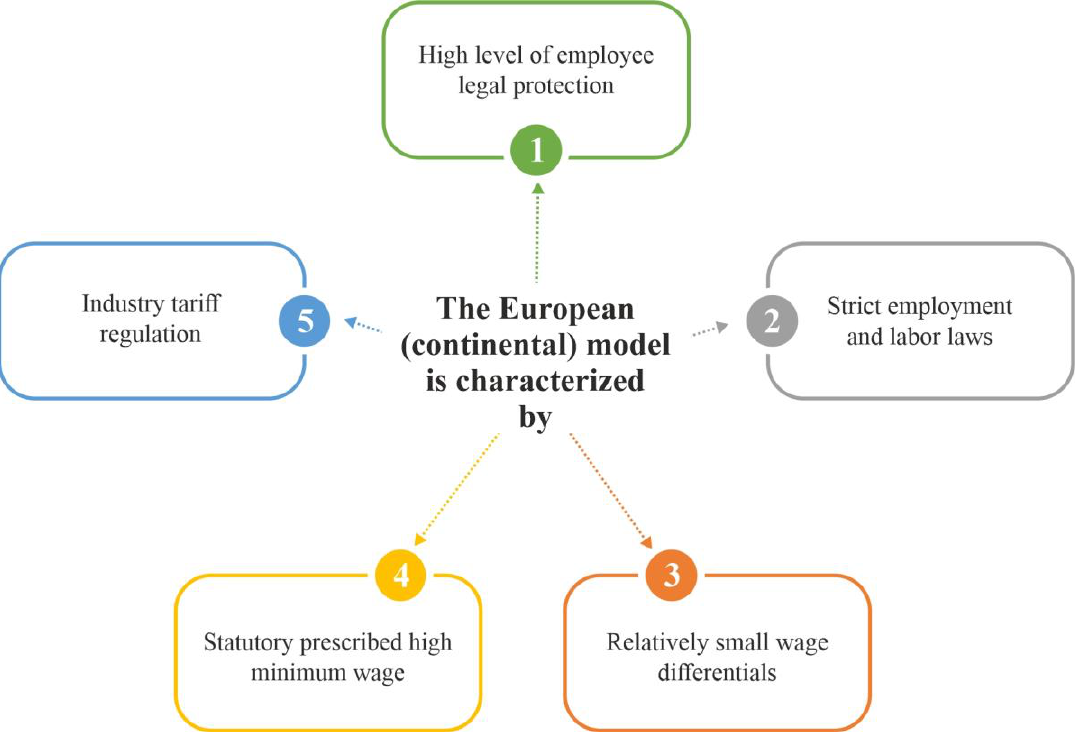
Figure 2. Features of the European (continental) model of social and labor